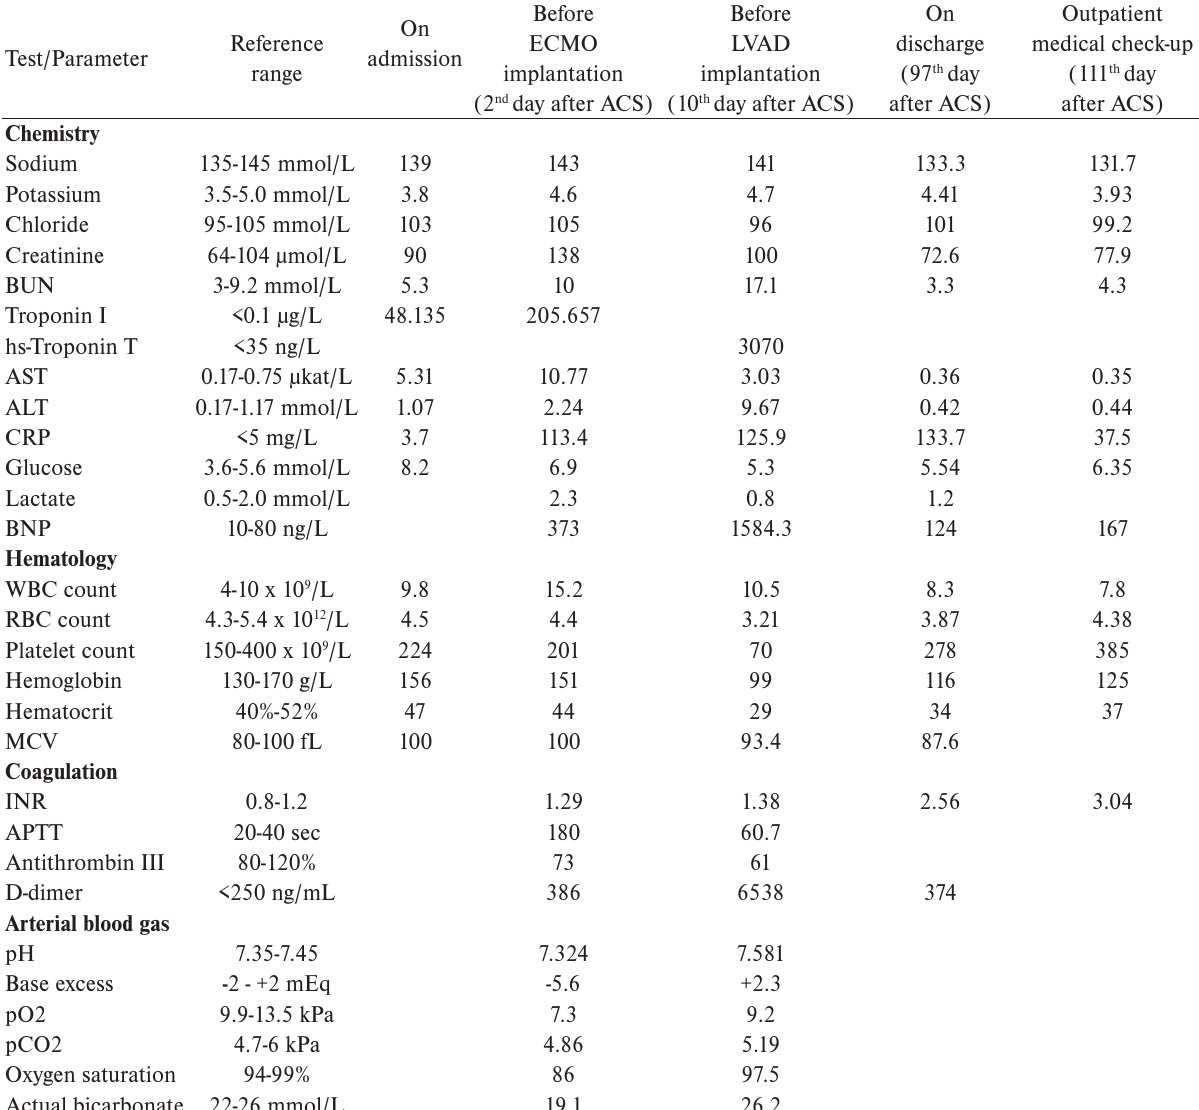
Table 1. Patient’s available laboratory